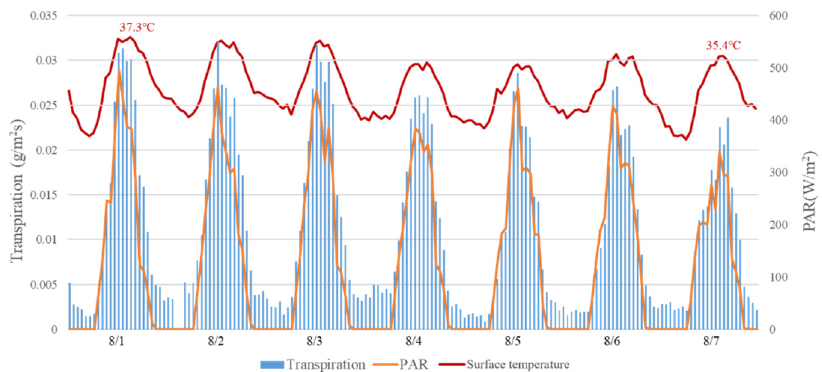
Figure 7. Temporal variation of the tree transpiration rate (bar) with PAR (orange line), and surface temperature (red line) of the top layer (building height: 1H, tree location: north, LAD distribution: C.D).